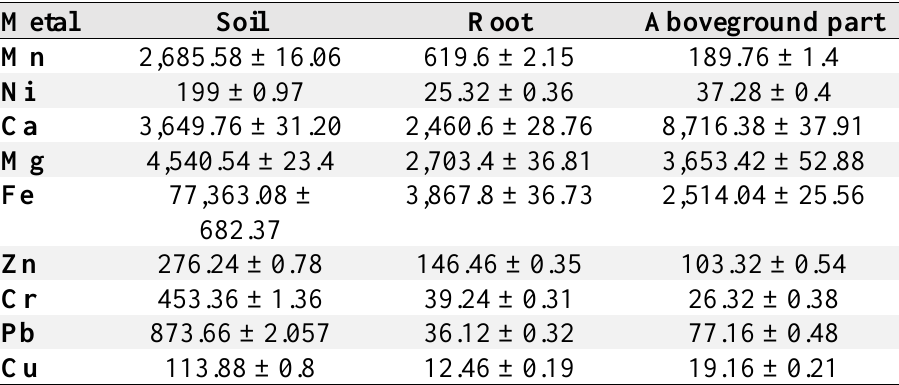
Table 2. The content of investigated metals (mg/kg) in soil, root and aboveground parts of Rumex